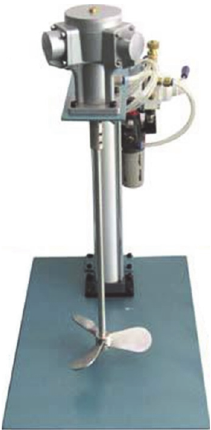
Figure 1: Explosion-proof pneumatic mixer.